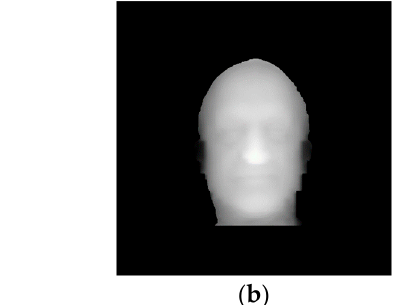
Figure 7. Inverse Fresnel transformation from the minus first spectral order of the hologram of focused images of the 3D object of holographing: ( a ) the amplitude of restored image; ( b ) phase. Collected together, after multiplying the depth by compression factor 1/ Ҟ fi xed pre- viously, they form the 3D object restored by the computer hologram (Figure 8).